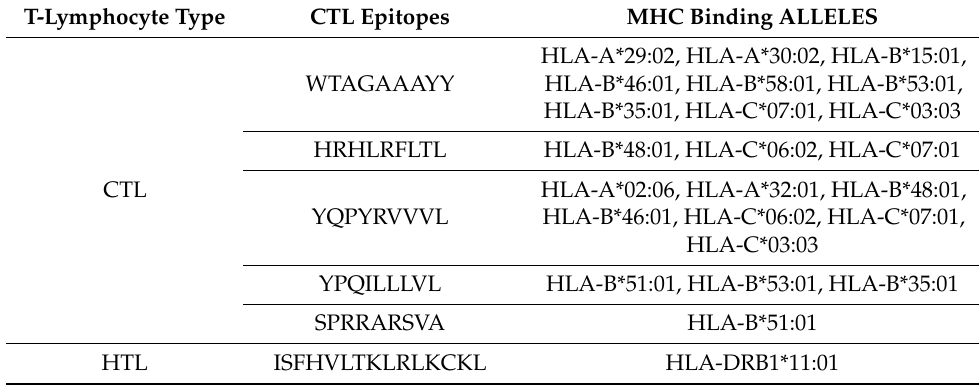
Table 2. Selected T-lymphocyte epitopes and their associated MHC alleles.